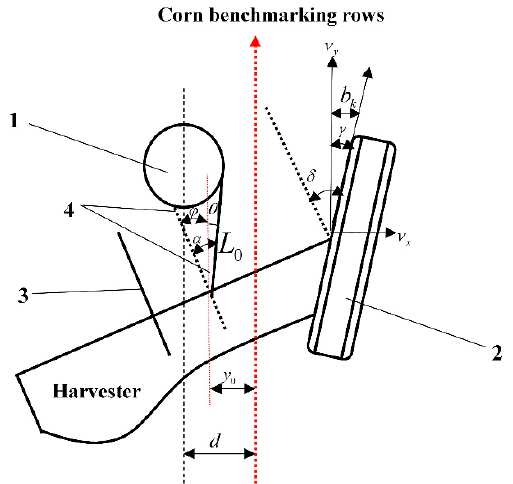
Figure 9. Harvester lateral offset modeling. (1) Corn stalk (2) Harvester steering wheels (3) Left touch lever (4) Right tough lever.